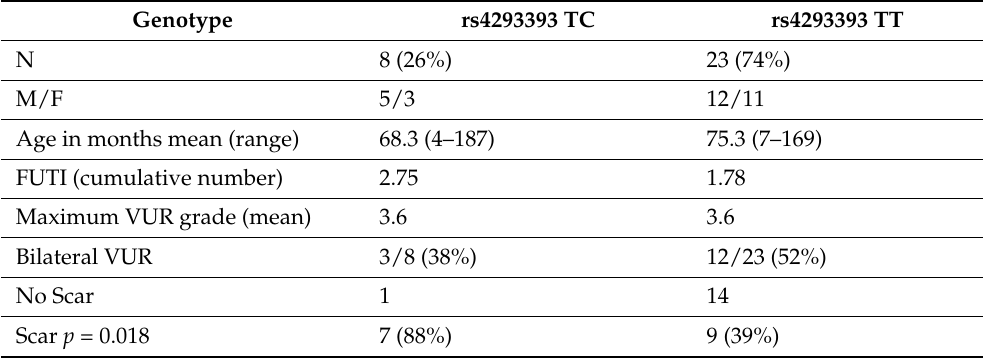
Table 2. Genotype at rs4293393 of Uromodulin in patients with VUR.